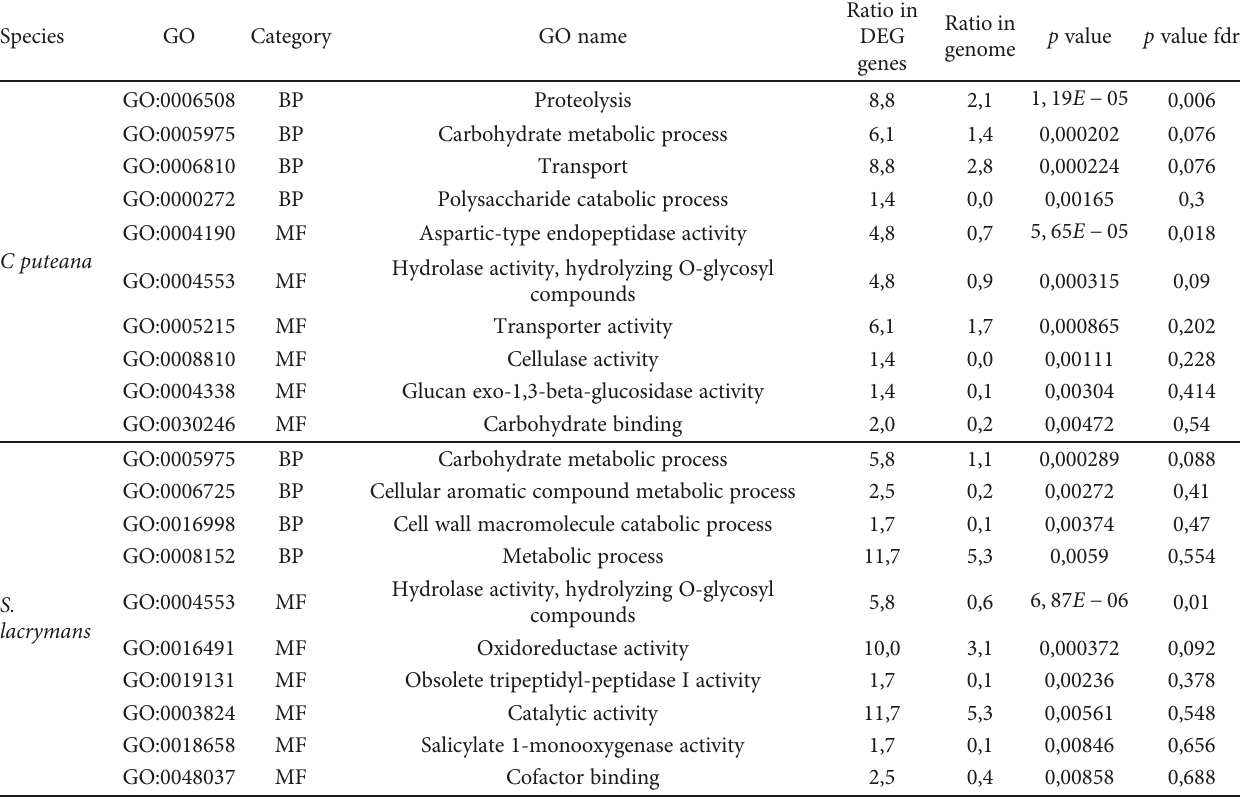
Table 2: Top ten enriched terms in C. puteana and S. lacrymans DEG genes with lncRNAs in their promoter region. Species